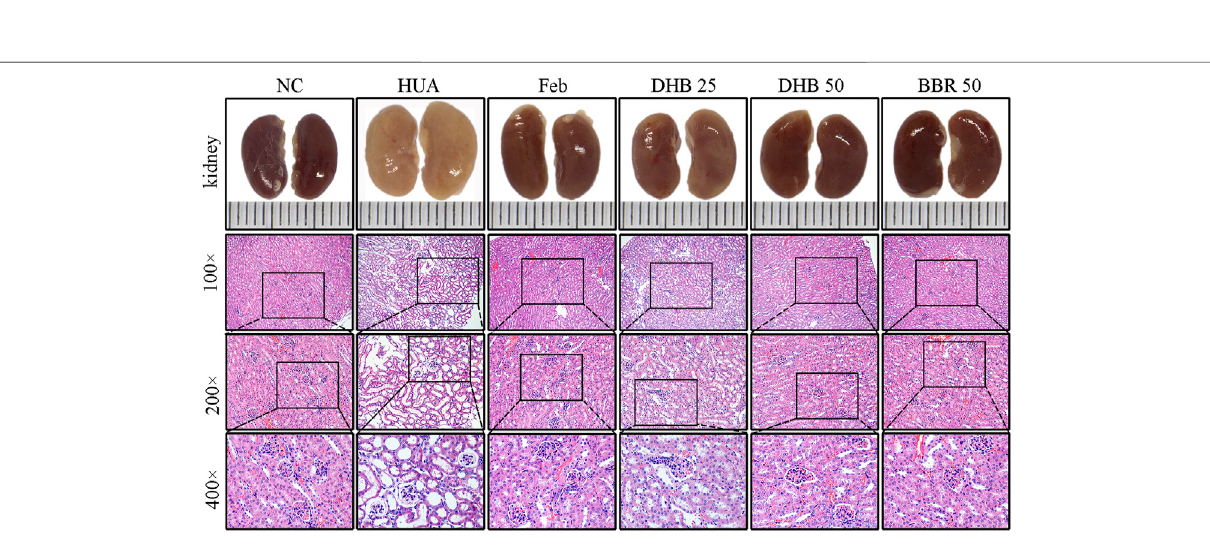
FIGURE3| EffectofDHBonkidneygeneralstatusandhistopathologicalchangesinPO/HX-inducedhyperuricemicmice.Grossappearanceofthekidneysfromall six groups were photographed, and sections were subjected to H&E staining; these representative photographs were taken at a magni fi cation of × 100, × 200, × 400,